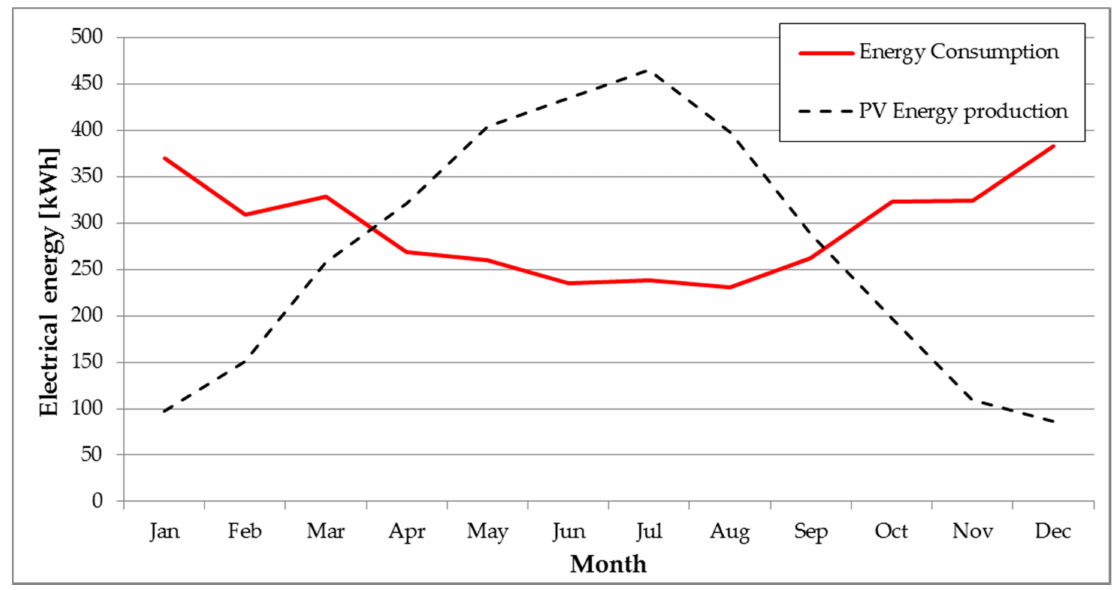
Figure 6. Monthly building electricity consumption in 2016 and estimated PV energy